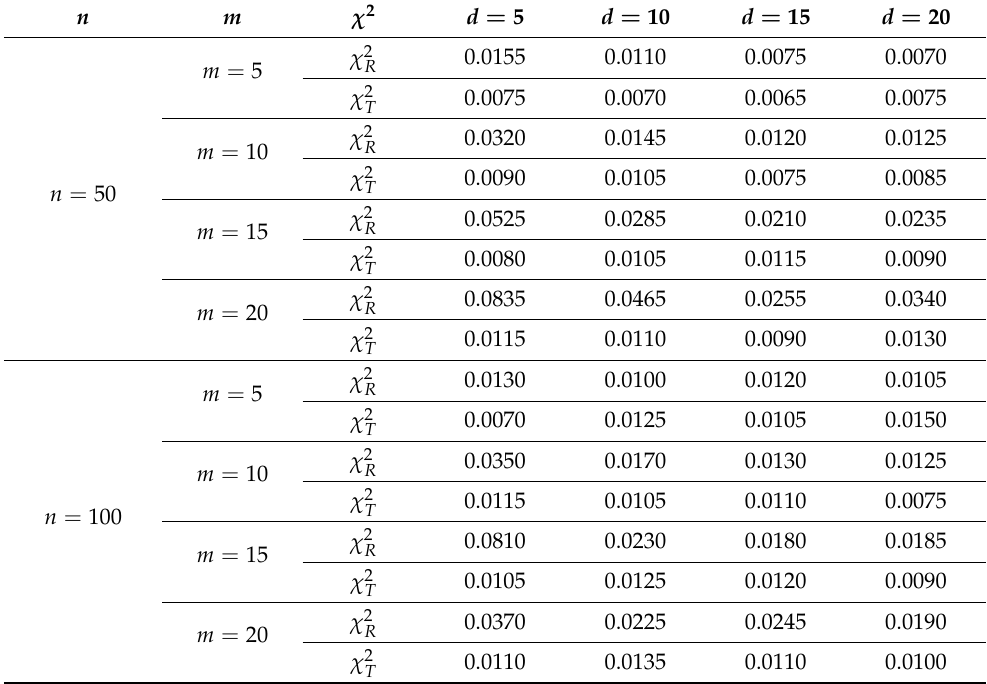
Table 1. Empirical type I error rates ( α =